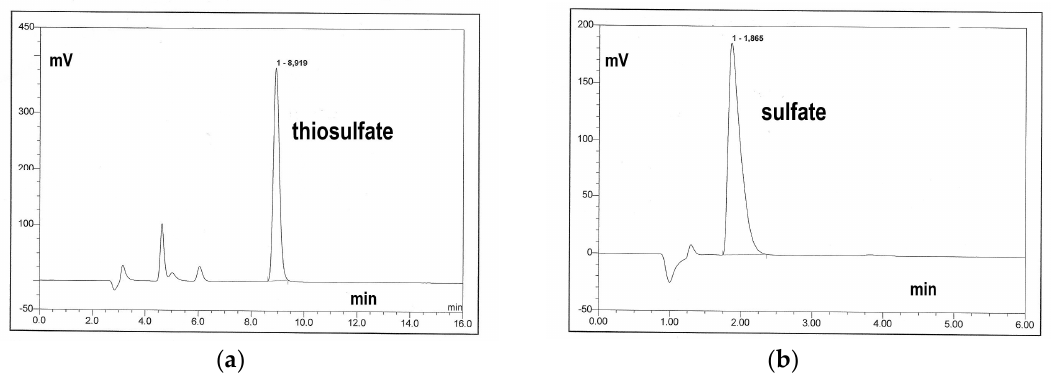
Figure 3. Chromatograms: ( a ) Initial solution; ( b ) Final solution.